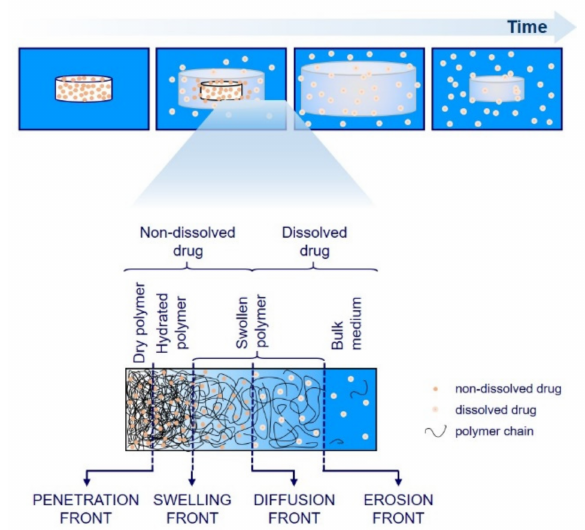
Figure 1. Schematic representation of swelling and drug release from the hydrophilic matrix tablets with di ff erent layers and